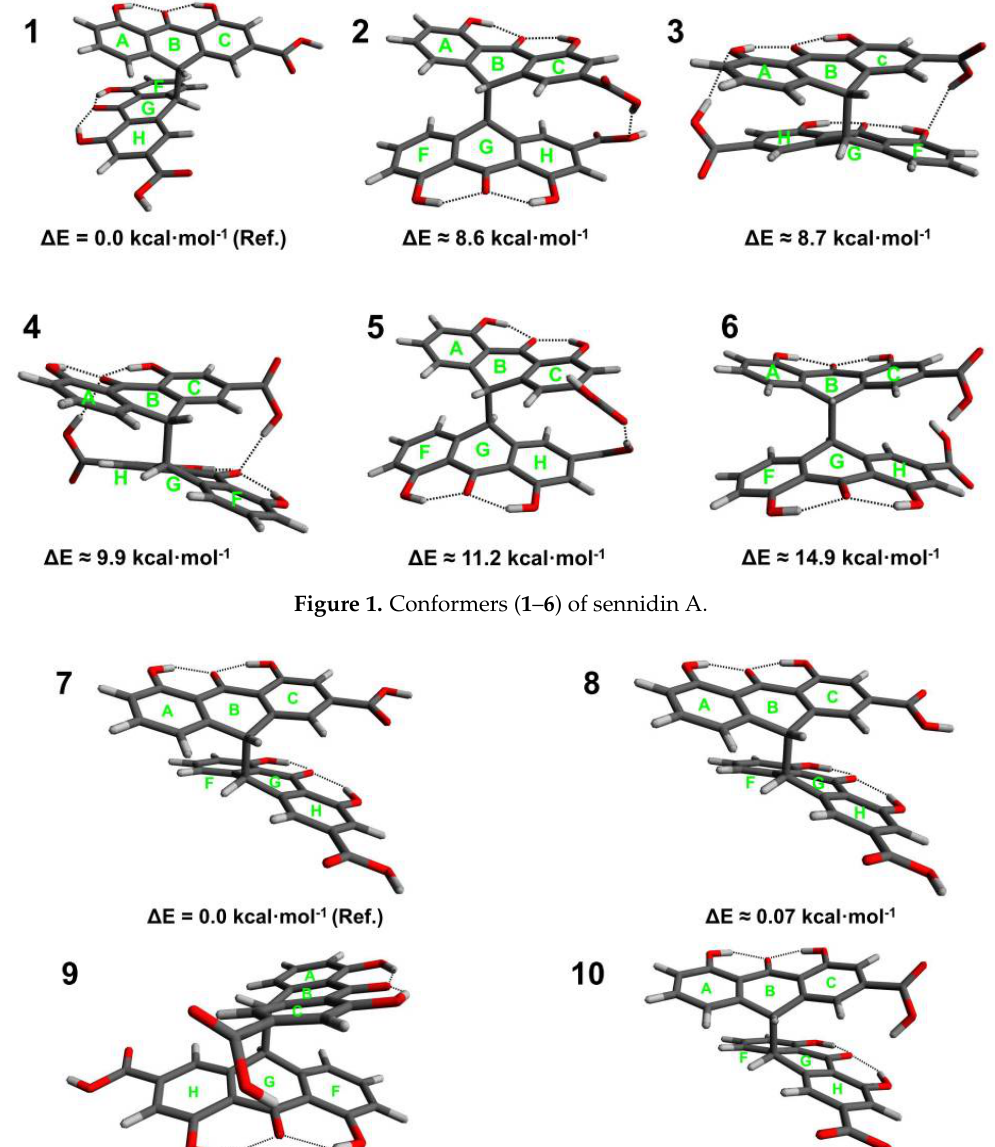
Figure 3. Conformers ( 11 – 16 ) of sennidin C. The structure of sennidin C can be described with 6 conformers (11–16). The maxi- mum energy difference is 5.9 kcal∙mol −1 . Conformer 11, with the lowest energy, is charac- terized by a non-stacking arrangement of the anthrone moieties. The substituents in “bay” region are arranged parallel to the plane of the C and H rings. A number of intramolecular interactions in the structure of sennidin C can be observed. Conformers 11–14 show